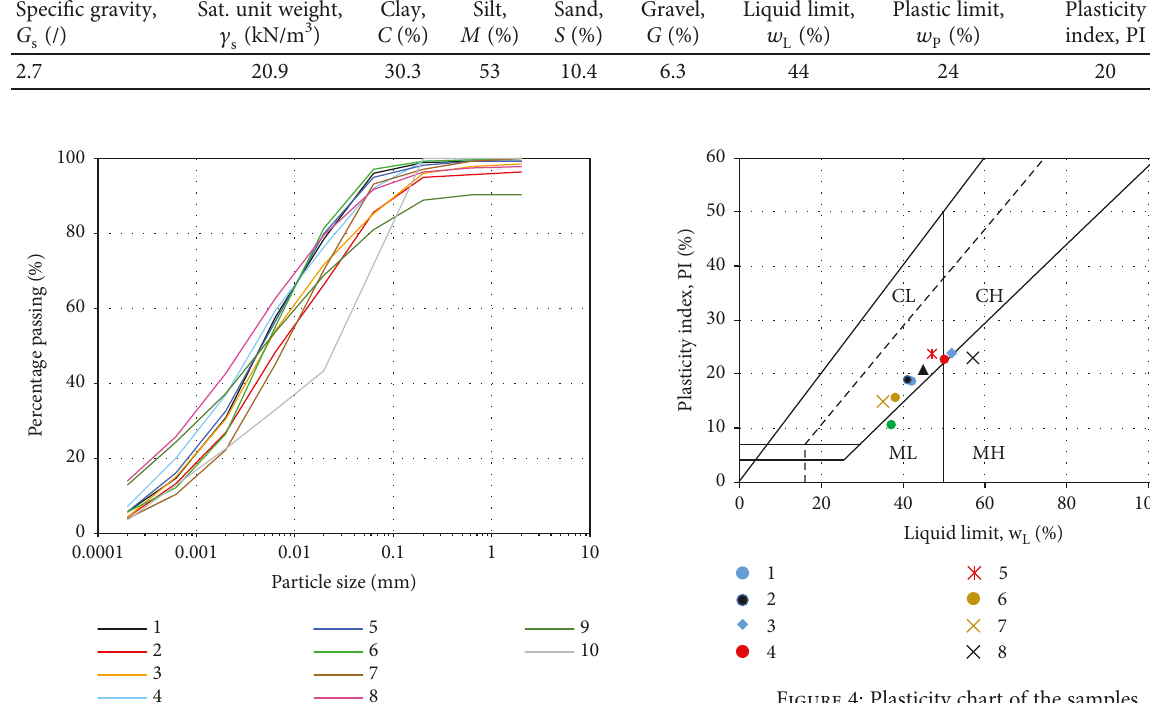
Figure 2: (a) Sampling pit. (b) Half of the oven-dried specimen from a depth of 0.75 m. Table 1: Mean values of the basic properties of the residual soil samples used in this study. Particle size distribution Atterberg limits